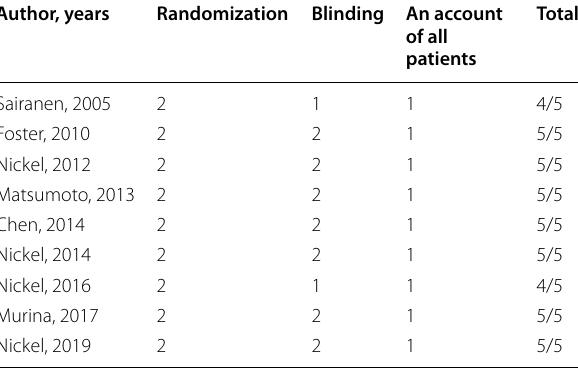
Quality assessment for randomized-controlled trial